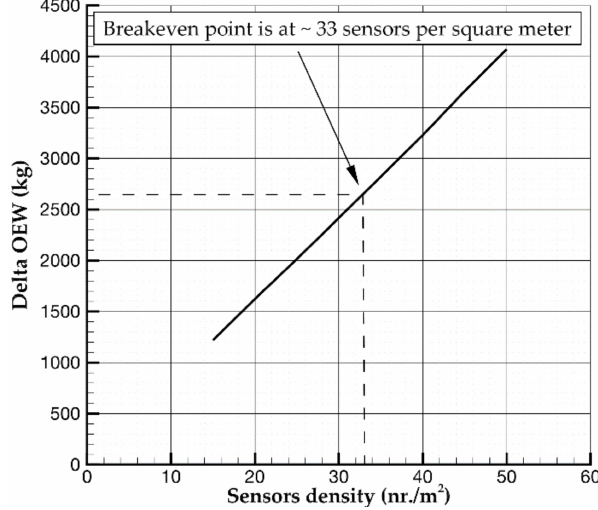
Figure 9. Breakeven point estimation for the reference aircraft: Delta OEW vs sensors density.